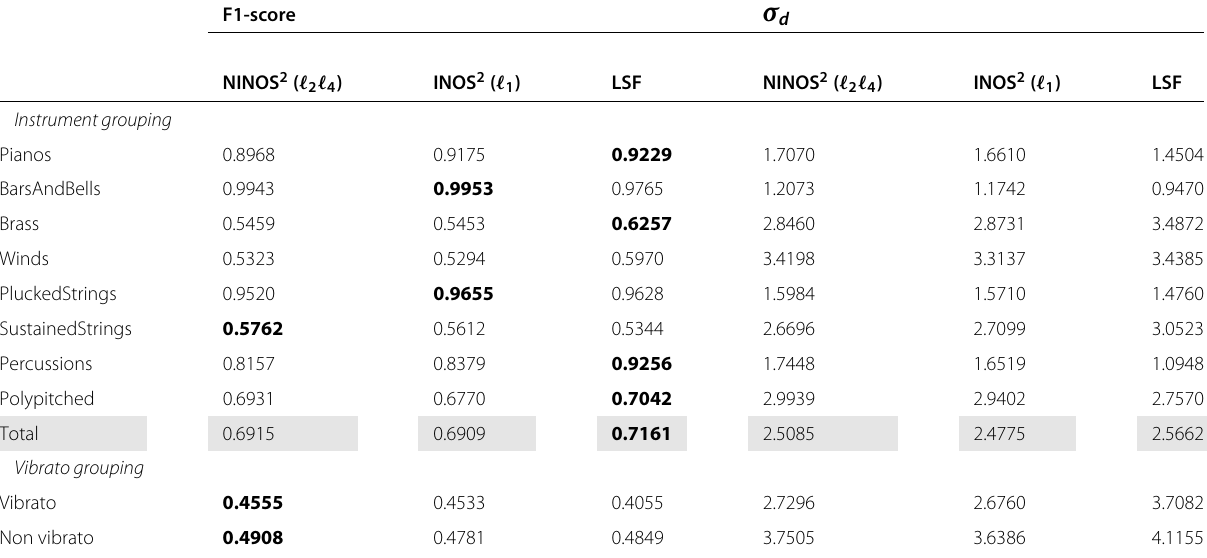
Table 4 NOD performance measures for MR8